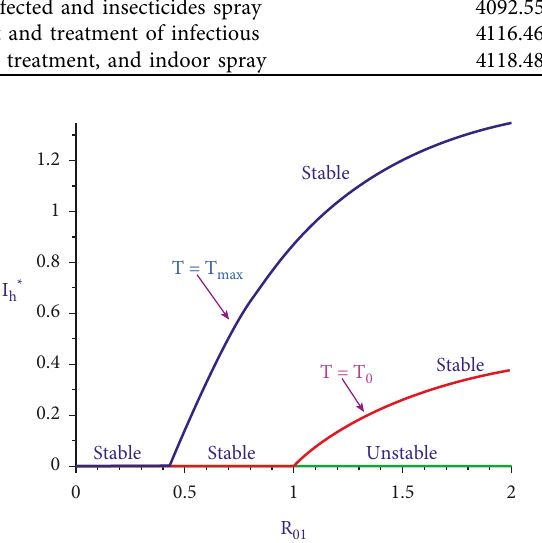
� T for the malaria model problem. 0 and T max